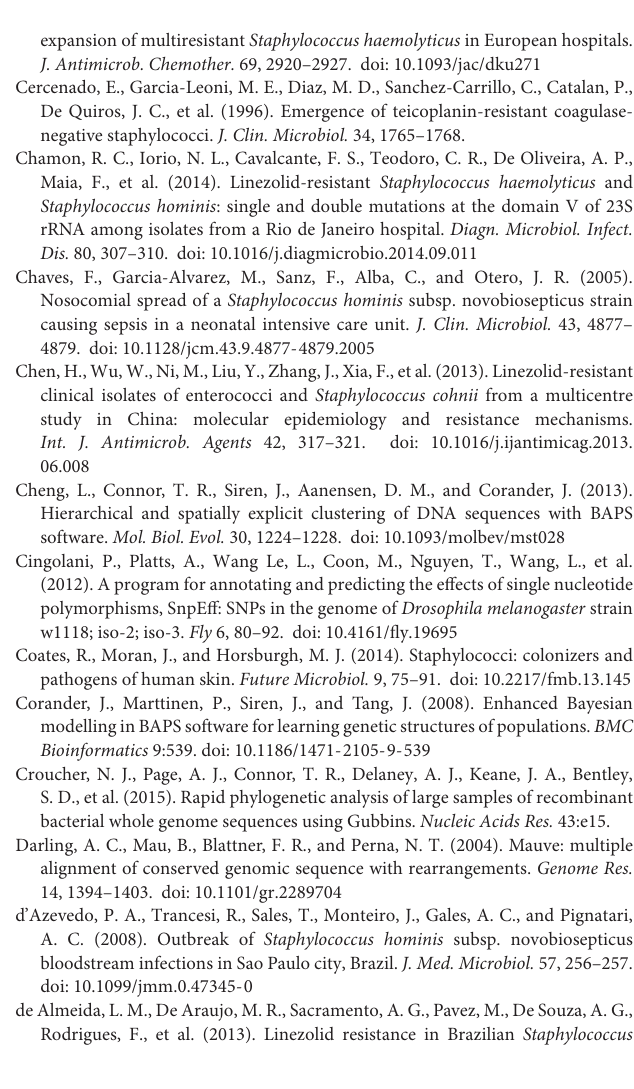
Supplementary Figure 1 | Maximum-likelihood phylogeny of S. epidermidis population based on core-SNP alignment with additional data and names of strains and description of calculated acquired resistance genes. Supplementary Figure 2 | Structure alignment of cfr -harboring plasmids. Supplementary Figure 3 | (A) Heat map of the distribution of AAS in proteins associated with decreased susceptibility to glycopeptides in S. epidermidis ; (B) Results of MCA analysis; (C) Distribution of isolates with PAP data, genotypes, and variants of mutations in RpoB. Supplementary Table 1 | Quality of sequence data. Supplementary Table 2 | Genomes included in the study. Supplementary Table 3 | Pairwise SNP differences between genomes of